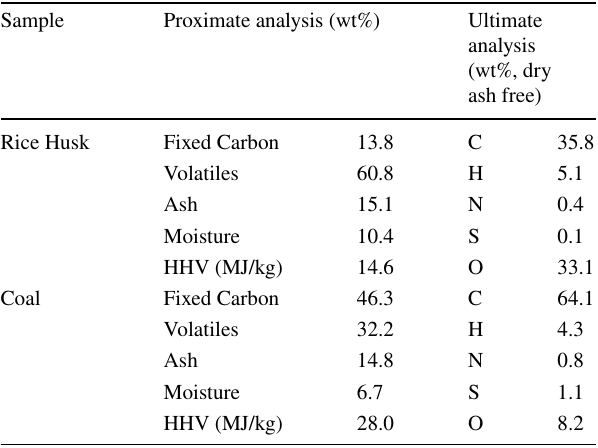
Table 1 Proximate and ultimate analysis of the fuels simulated in this study (based on Wu et al. 2019) Sample